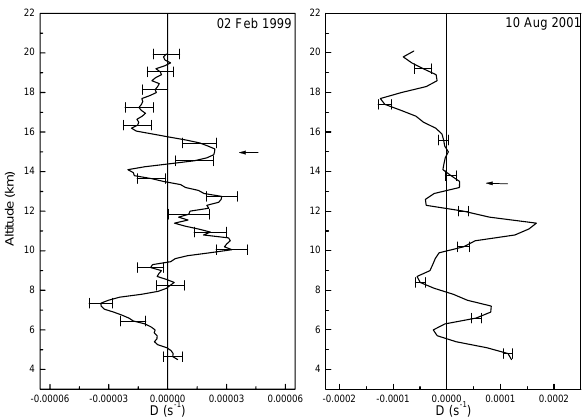
Fig. 1. Altitude profiles of D for 2 February 1999 and 10 August 2001.